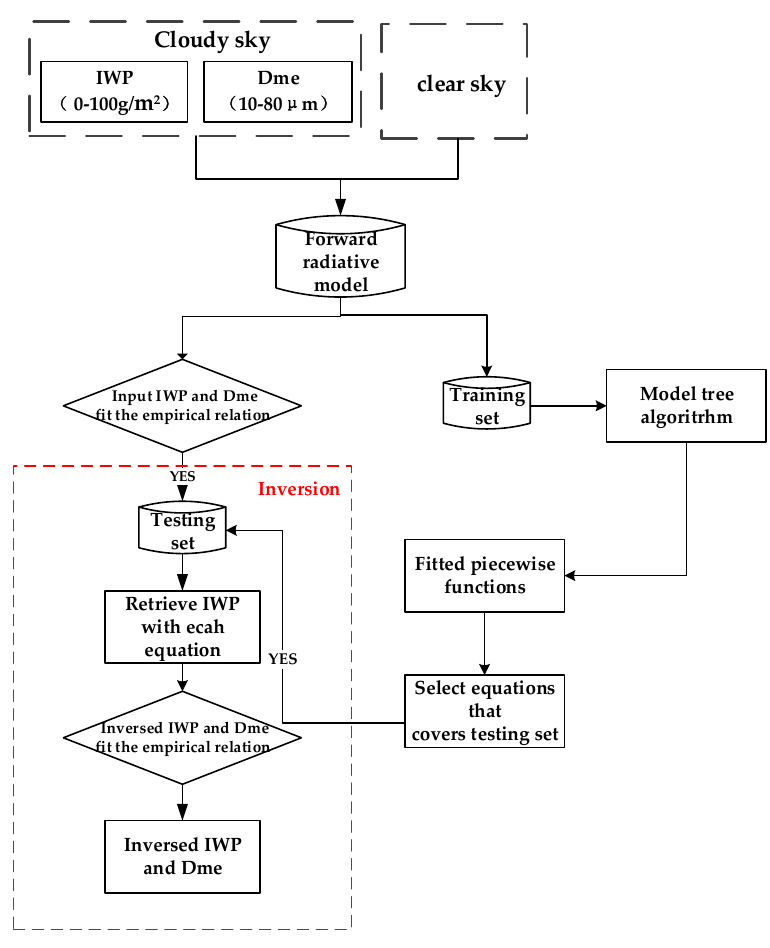
Figure 4. The process of single-channel